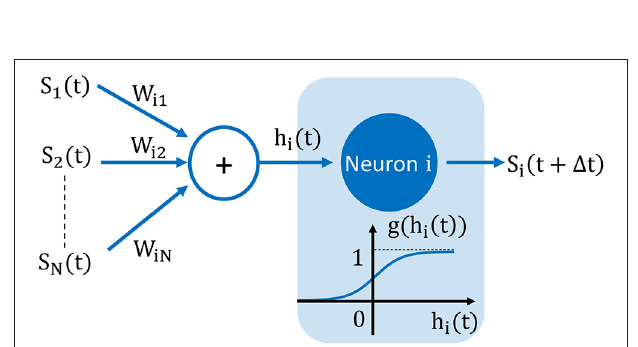
FIGURE 10 | Model of artificial neuron used to construct our mapping function µ N . The neuron’s output state S i ( t ) is either +1 or –1 and is dynamically updated at each time-step 1 t according to the sigmoid activation function g . Here, g gives the probability to have one of the two states at t + 1 t for a given input weighted sum h i ( t ).